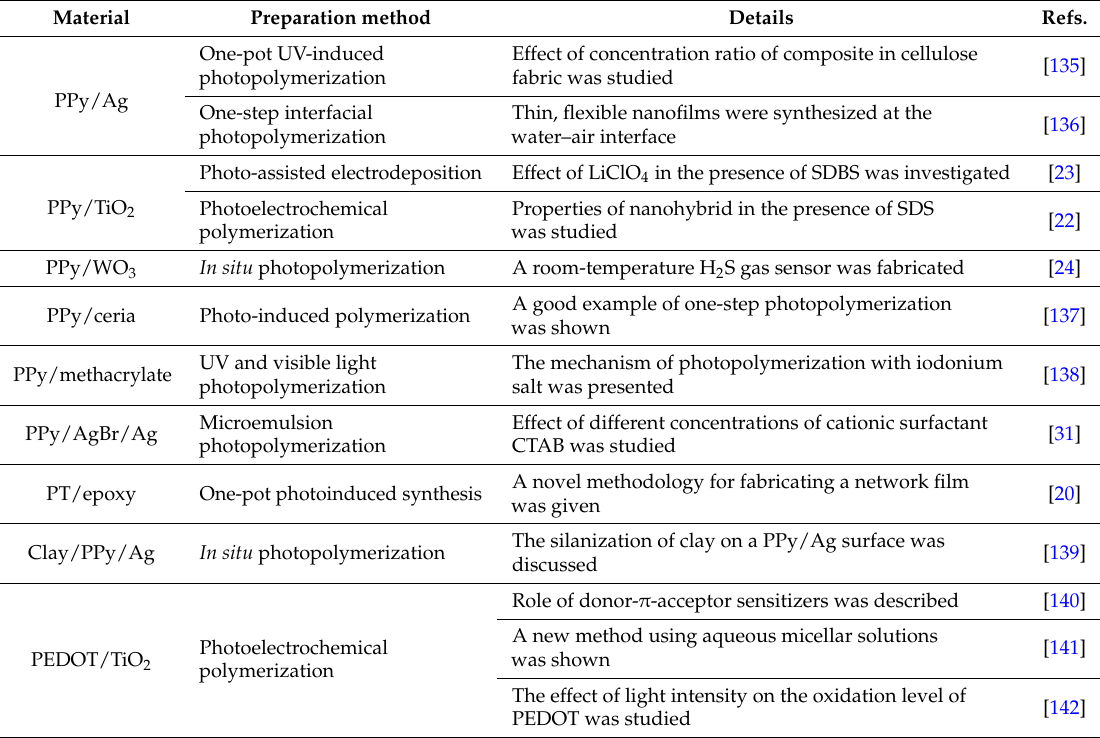
Table 7. Representative examples for photosynthesis of CP